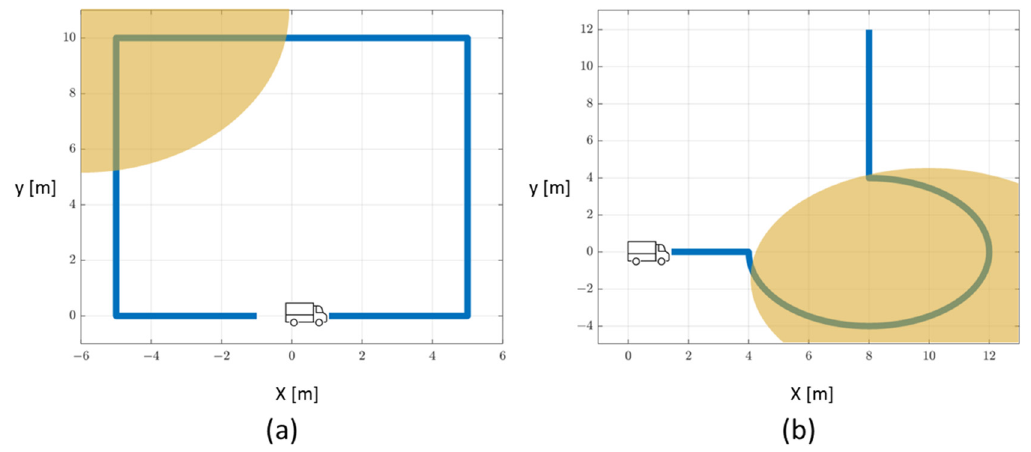
Figure 16. Jamming zones overlaid onto the preset plans for the lead vehicle: ( a ) square loop and ( b ) roundabout.